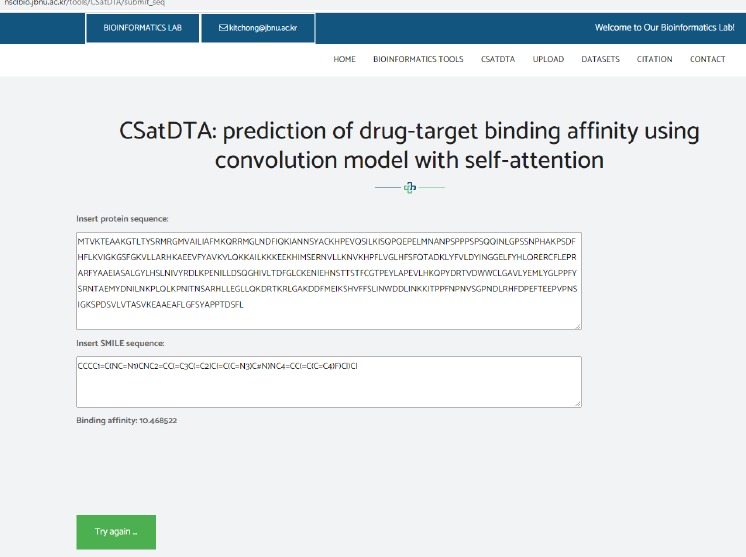
Figure 3. Snapshot of webserver showing binding affinity